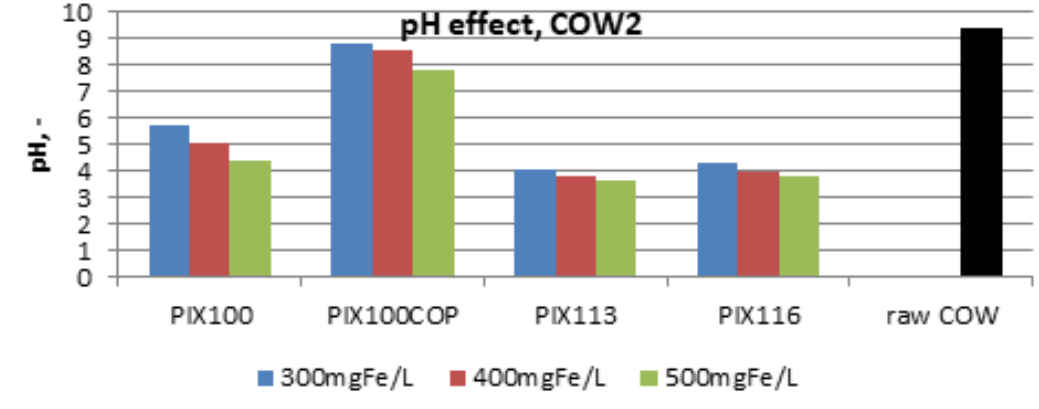
Figure 17: Effect of coagulant type and dose on pH of COW2.